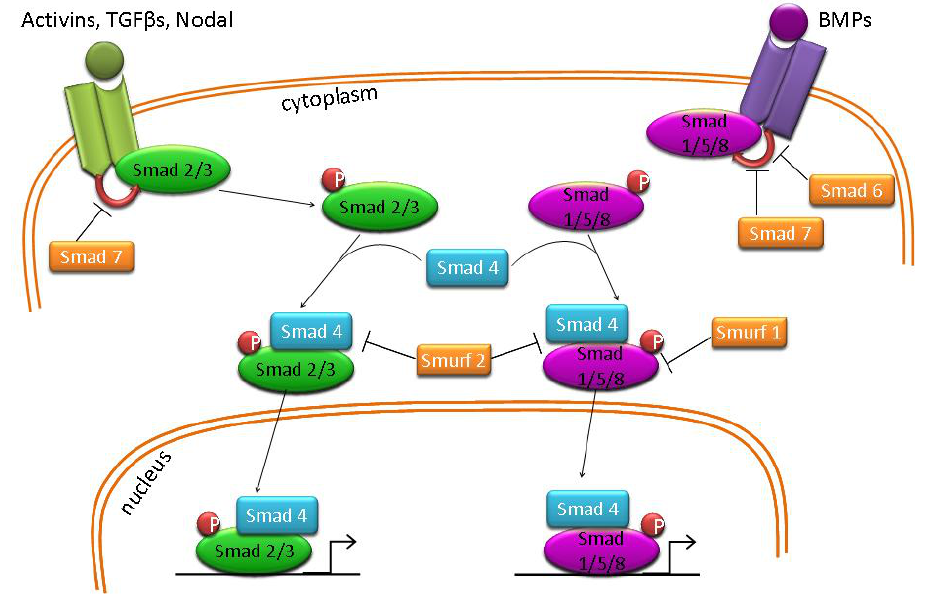
Figure 3. Diagrammatic representation of Activin, Nodal, TGFβ and BMP signaling